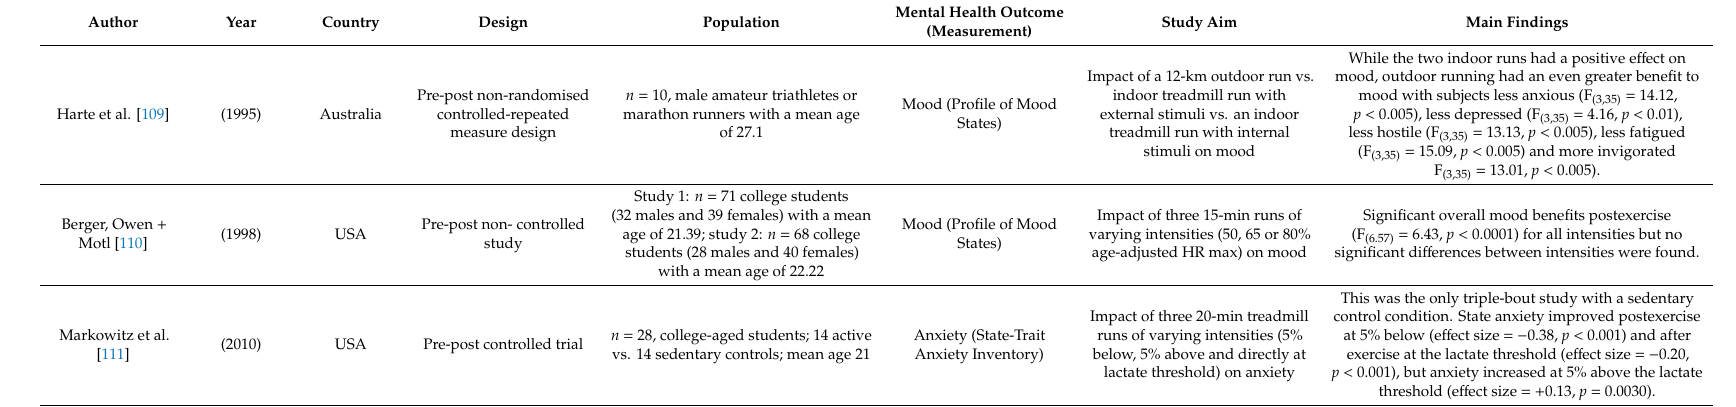
Table 5. Summary of data extraction from the 3 triple-bout